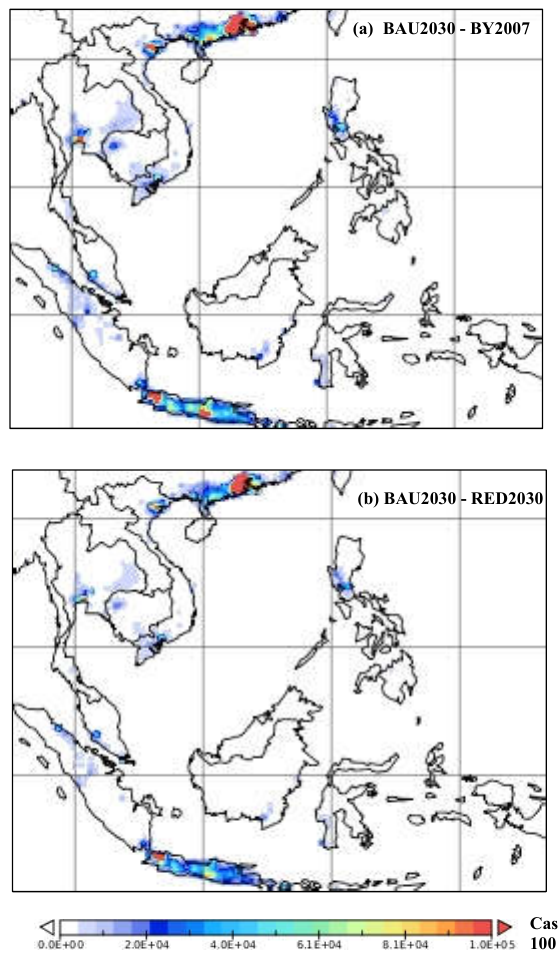
Figure 3. The difference in the number of mortality cases (cases per 100000 people) between BAU2030 and BY2007 (BAU2030 − BY2007) and between BAU2030 and RED2030 (BAU2030 −